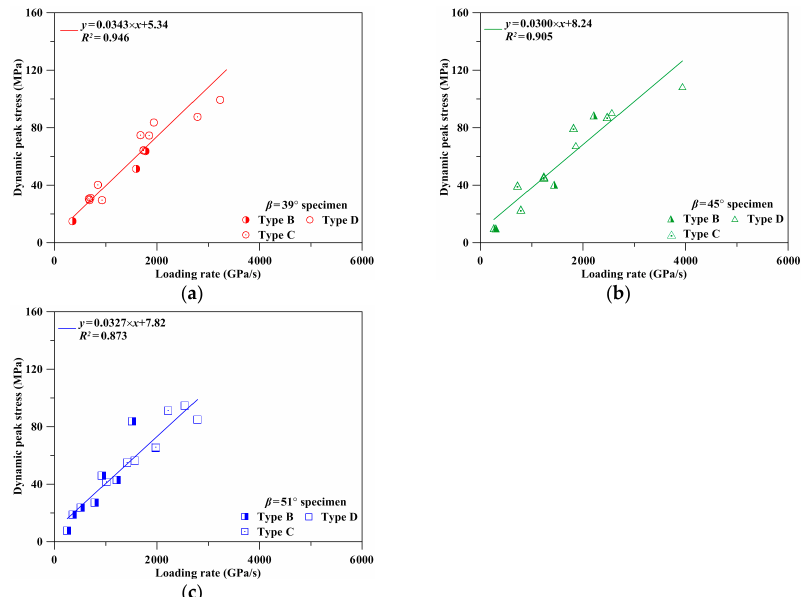
Figure 9. Relationship between dynamic peak stress/strength and loading rate of planar joint specimens with β = 39°, 45°, and 51° ( a – c ).